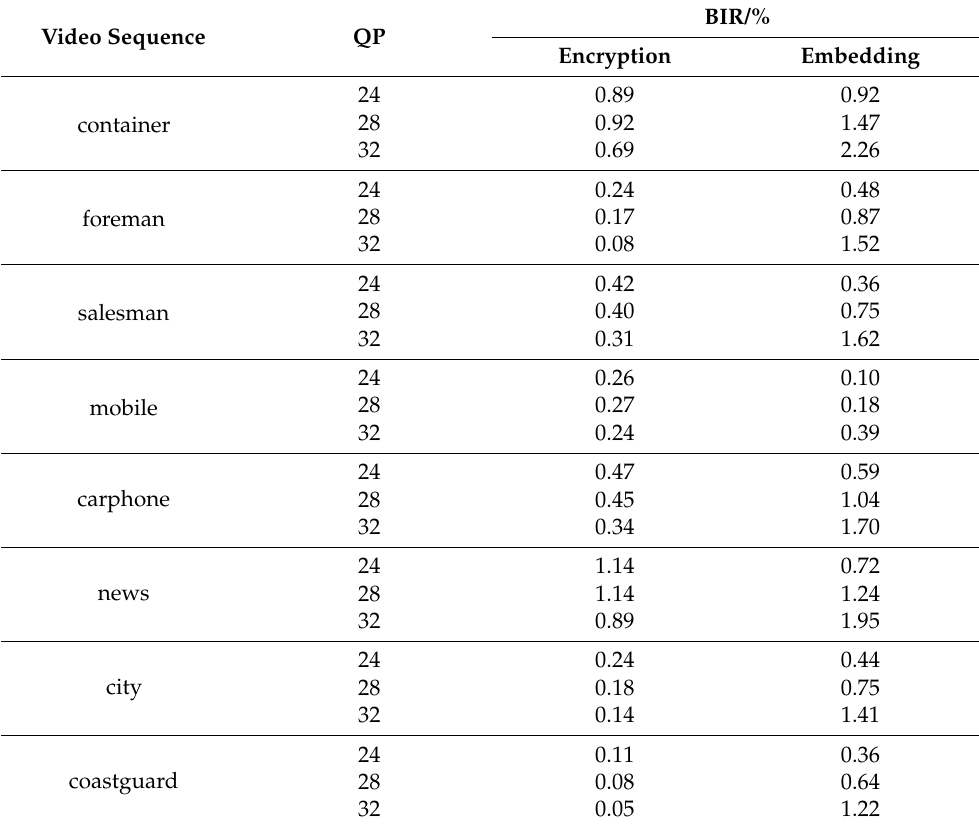
Table 4. BIR due to encryption and